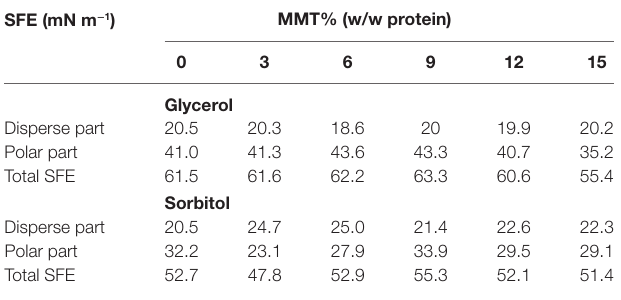
TaBle 5 | Effect of an increasing montmorillonite (MMT) nanofiller-loading and varying plasticizer type (glycerol or sorbitol) on the disperse fraction, polar fraction, and total surface free energy (SFE) of WPI-based (10% (w/w dispersion), 66.70% (w/w protein) plasticizer) nanocomposite cast films (200 µm